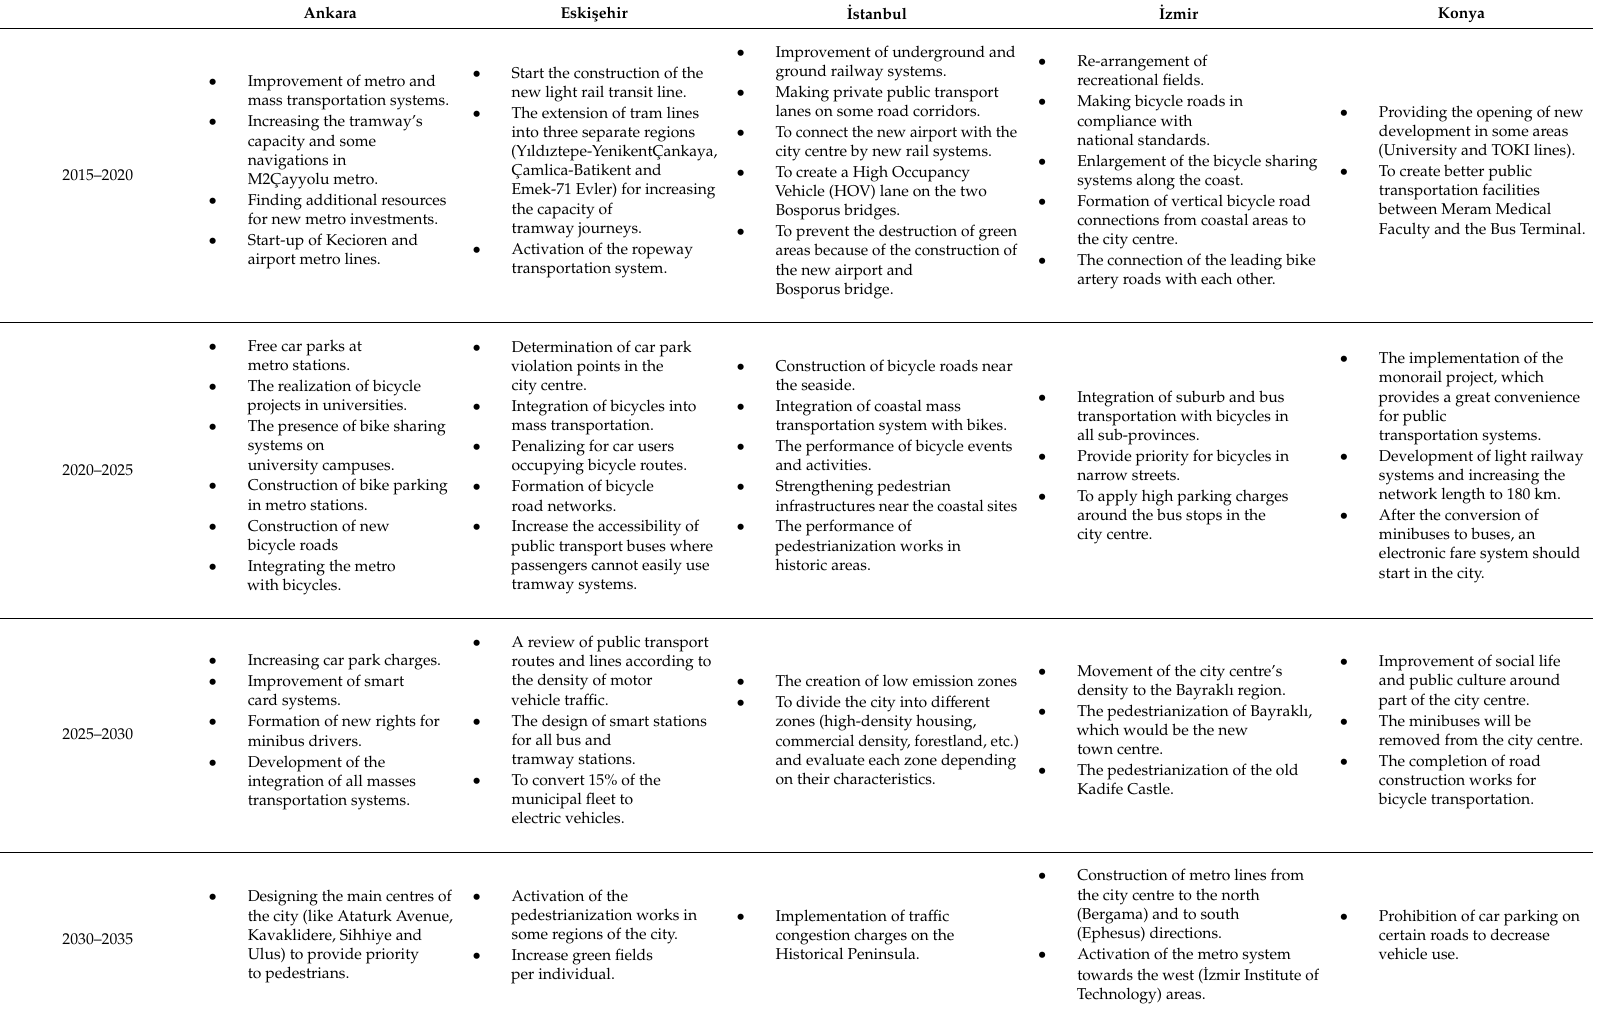
Table 4. Local policy pathways for Improve Vision applied in the selected Turkish urban